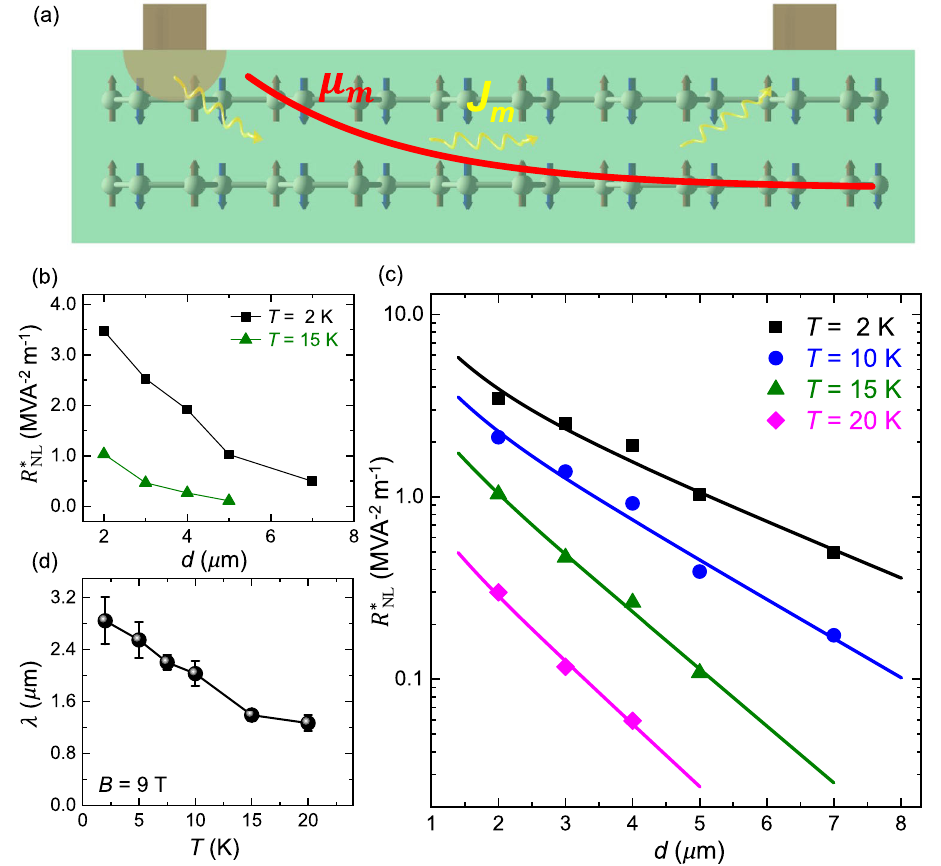
FIG. 3. The measurement of magnonic properties in quasi-2D antiferromagnet MnPS 3 . (a) Schematic of the exponential decay (solid red line) of magnon-dependent chemical potential ( μ m ) during the flow of magnon-mediated spin current ( J m ). For simplicity, the magnon depletion below the Pt injector is not shown here (see Supplemental Material, Fig. S9 for details). (b) The spacing ( d ) dependence of the normalized nonlocal spin signals ( R (cid:2) ) of the 16-nm MnPS 3 device measured at T ¼ 2 and 15 K. (c) The spacing ( d ) NL ). The solid lines represent the best-fitting results based on Eq. (3). (d) The dependence of the normalized nonlocal spin signals ( R (cid:2) NL temperature dependence of the magnon relaxation length for the 16-nm MnPS 3